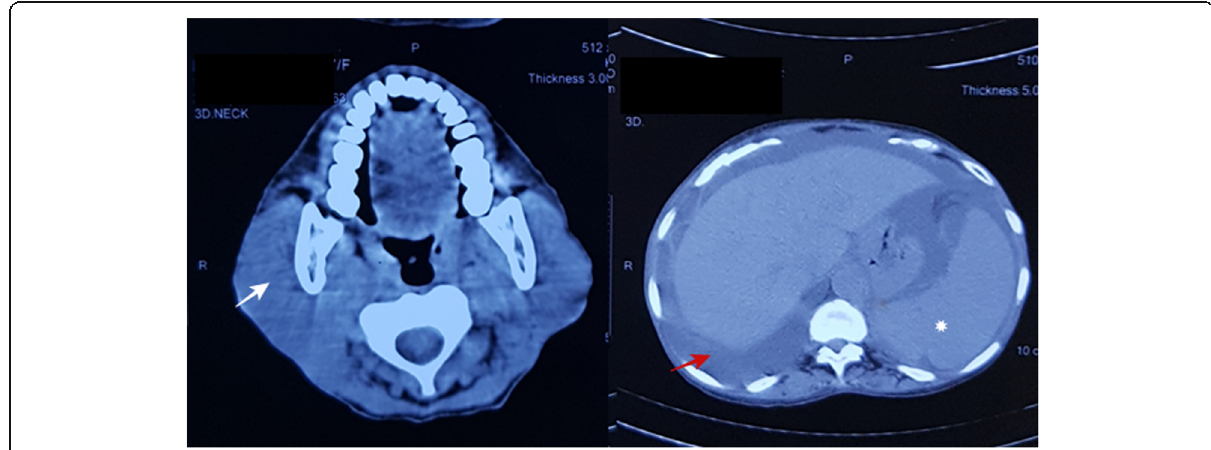
Fig. 2 a NCCT neck showing a mass lesion in the region of parotid and level II with focal extension to paravertebral space and obliteration of parapharyngeal space (white arrow). b NCCT abdomen showing splenomegaly (star) and ascites (red